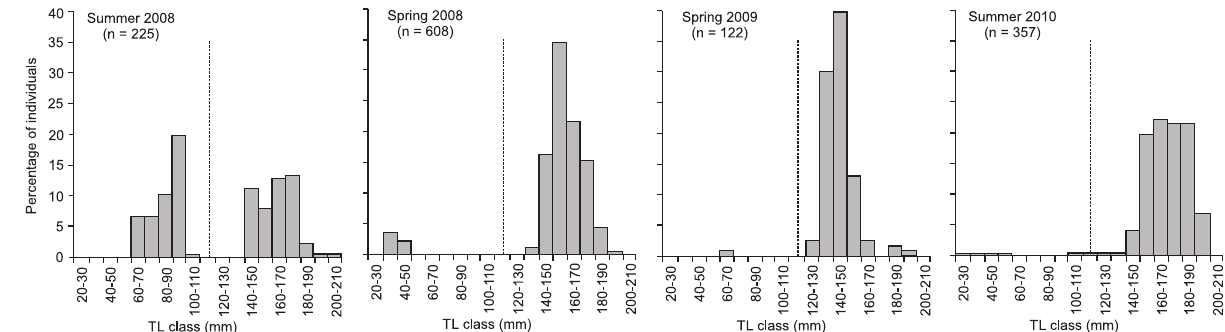
Figure 4. Trachurus lathami : length frequency distribution by period (dashed line indicates the average length of first maturity, L